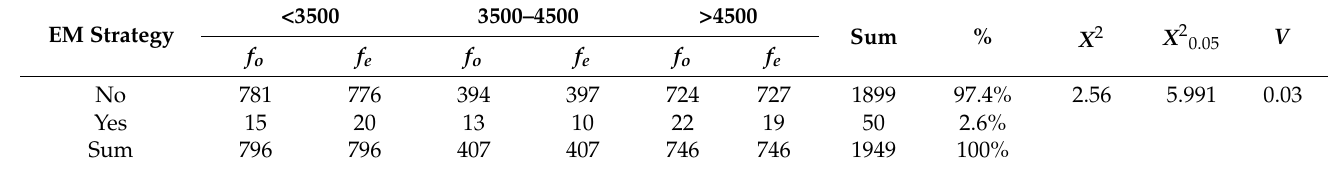
Table 2. Number of communes that decided to develop or not develop an electromobility strategy.